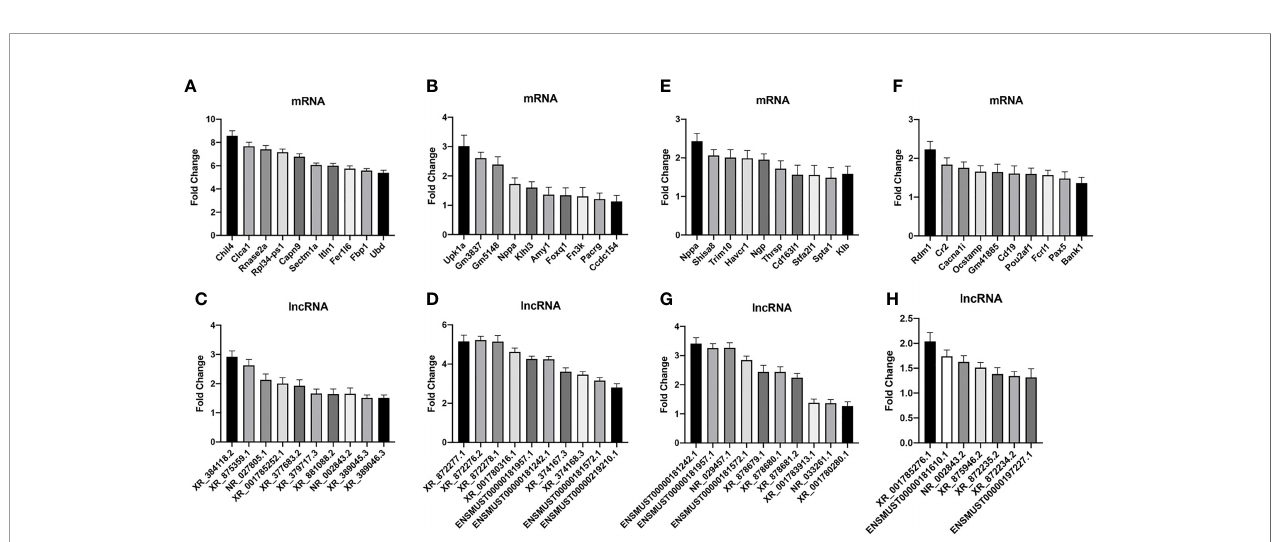
FIGURE 7 | Real-time PCR (RT-PCR) validation of differentially expressed mRNA and lncRNA among the groups. Compared with the control group, differentially expressed mRNAs in WT-PCP mice were shown in (A) (upregulated) and (B) (downregulated) and differentially expressed lncRNAs were shown in (C) (upregulated) and (D) (downregulated). In comparison with WT-PCP mice, differentially expressed mRNAs in BAFF-R – / – PCP mice were demonstrated in (E) (upregulated) and (F) (downregulated) and differentially expressed lncRNAs in (G) (upregulated) and (H) (downregulated). All P <